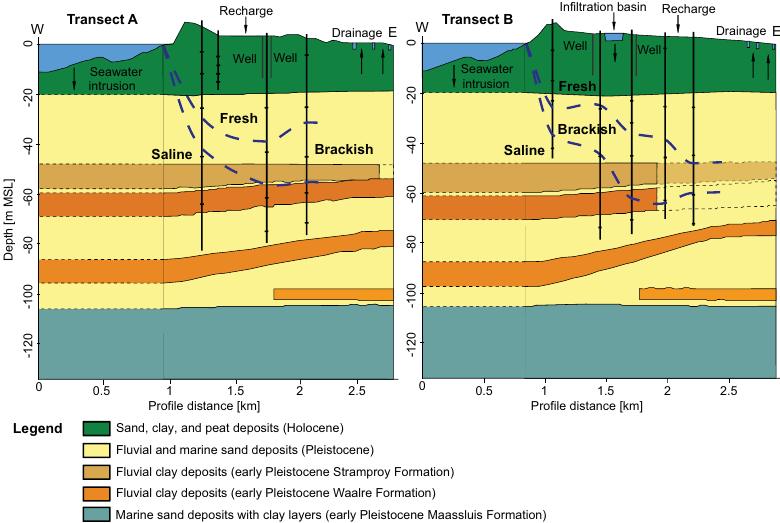
Figure 3. Geological profiles (based on the databases of the Geological Survey of the Netherlands) across the model domain with conceptual fresh–salt water distribution (locations are shown in Fig. 2).